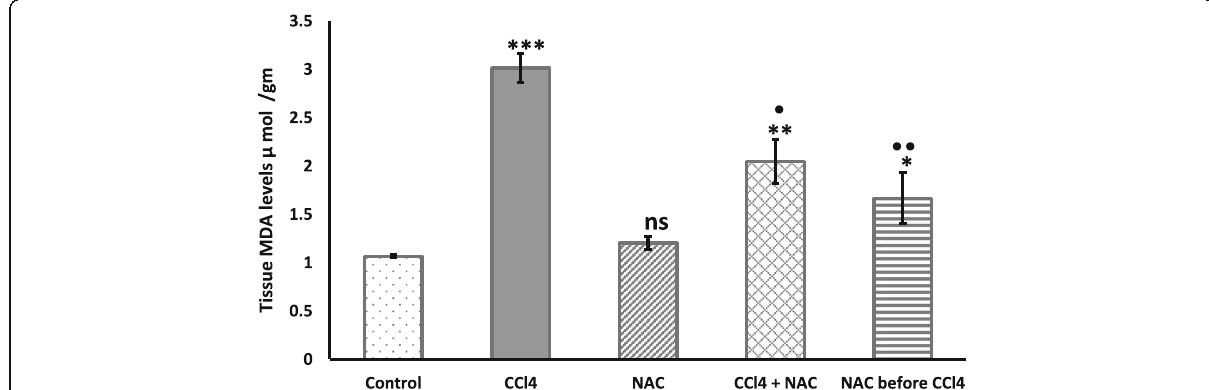
Fig. 1 Mean, SEM, and significance of MDA content in liver tissue in different groups. ns P > 0.05 compared with control. * P < 0.05 compared with control. ** P < 0.01 compared with control. *** P < 0.001 compared with control. (cid:129) P < 0.01 compared with CCL4. (cid:129)(cid:129) P < 0.001 compared with CCL4